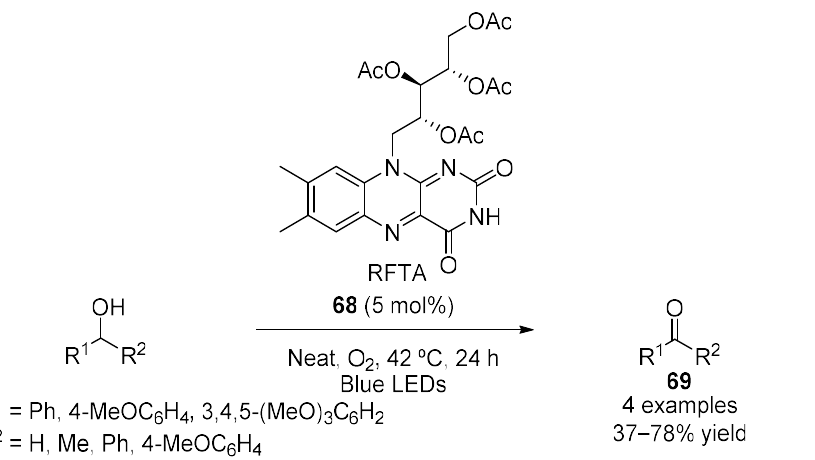
Scheme 17. Aerobic photo-oxidation of primary and secondary alcohols, including fluorenol, cata- lyzed by 68 .